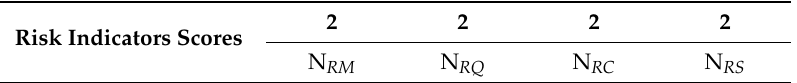
Table 13. Scores of the four risk indicators for the product “Urban Crosstown